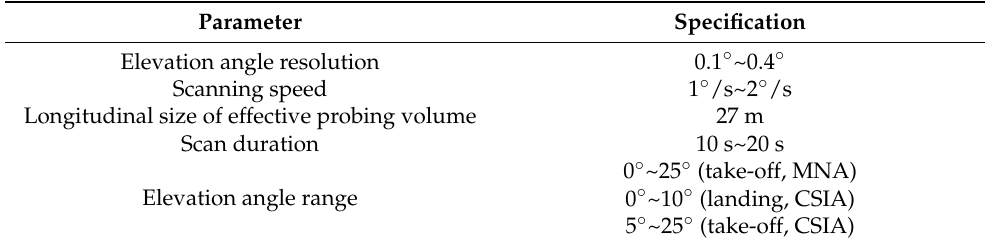
Table 3. Experimental parameters of the PCDL range height indicator (RHI) scanning strategy during the